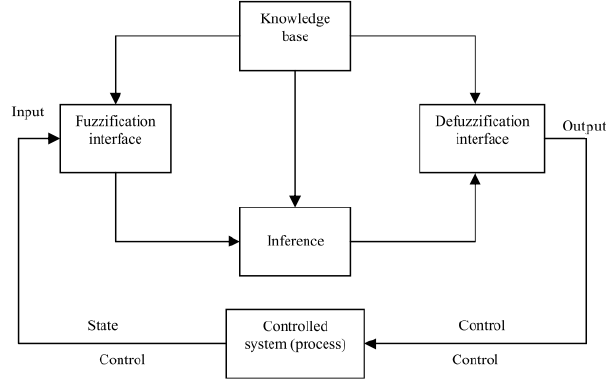
Figure 1. Configuration of a FLC